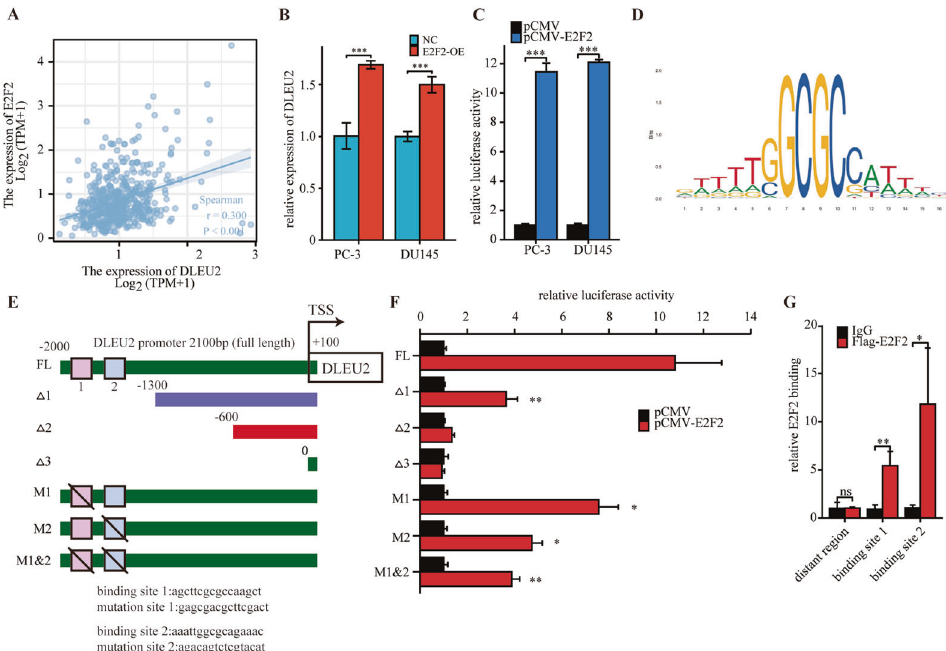
Fig. 6 DLEU2 transcription was activated by aberrant expression of E2F2. A Correlation between E2F2 expression and DLEU2 expression in TCGA database using spearman analysis. B Relative expression of DLEU2 in PC-3 and DU145 cells transfected with E2F2 using RT-qPCR. C Relative luciferase reporter assays in PC-3 and DU145 cells after the co-transfection of plasmid constructs containing the DLEU2 promoter with a E2F2 overexpressing construct. D The DNA motif for E2F2 was obtained from JASPAR. E E2F2 binding sites in DLEU2 promoter were predicted by JASPAR. F Relative luciferase reporter assays in PC-3 cells after the co-transfection of a series of truncated and mutated DLEU2 promoter with a E2F2 overexpressing construct. G ChIP assay demonstrated the direct interactions between E2F2 and DLEU2 promoters in prostate cancer cells. Data were indicated as mean±SD, ns P ≥ 0.05, * P <0.05, ** P <0.01, *** P